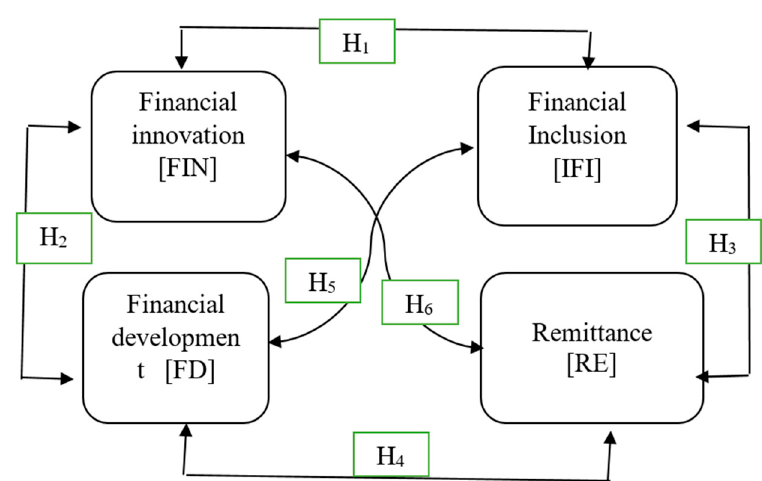
Figure 1. Conceptual framework of the possible pattern of causality between the variables.